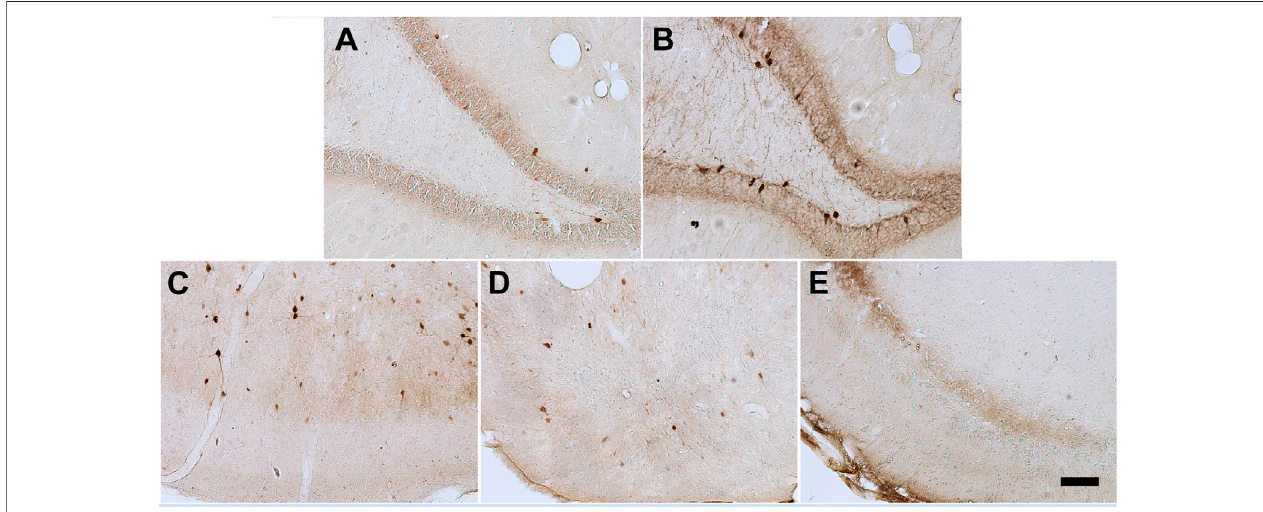
FIGURE 8 | Photomicrographs of PV + cells in the different brain regions. Hippocampal dentate gyrus and hilus in Non-Anxious (A) and Anxious (B) animals. Piriform cortex in Control (C) , NoSE (D) and SE (E) animals. Note increased number of PV + cells in the animal of the Anx group as compared to Non-Anx group and decreased PV density in NoSE and SE animals as compared to Controls. Scale bar: 100 µm.